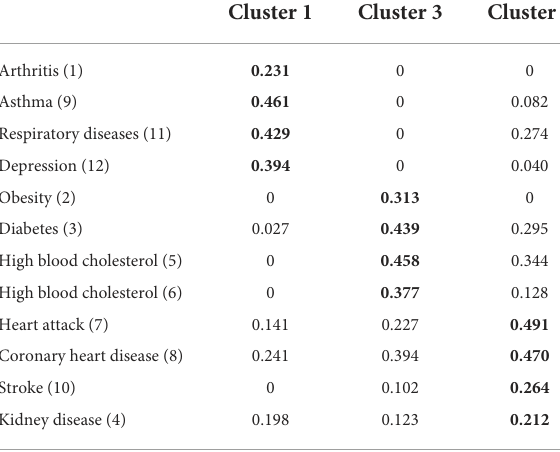
TABLE 3 Loads of chronic conditions in clusters in the